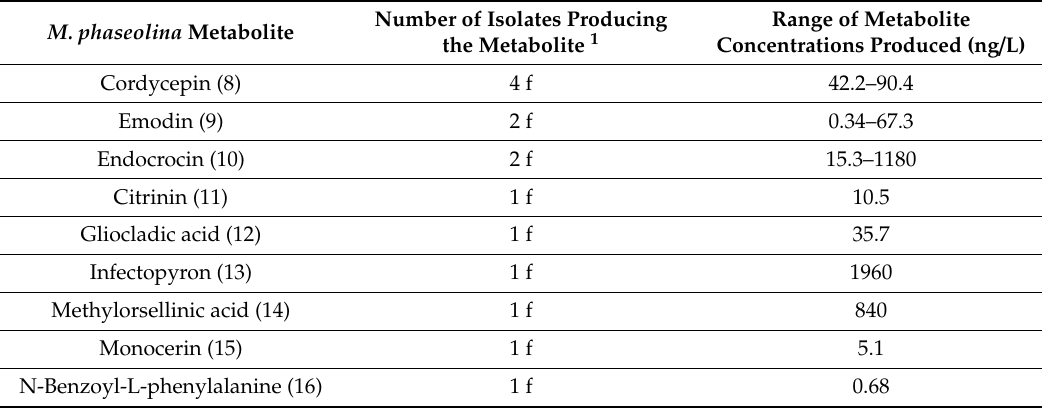
Table 3. Mycotoxins and other secondary metabolites occurring in the culture media of relatively few ( < 5%) of the 89 M. phaseolina isolates from soybean plants symptomatic for charcoal rot included in the study.